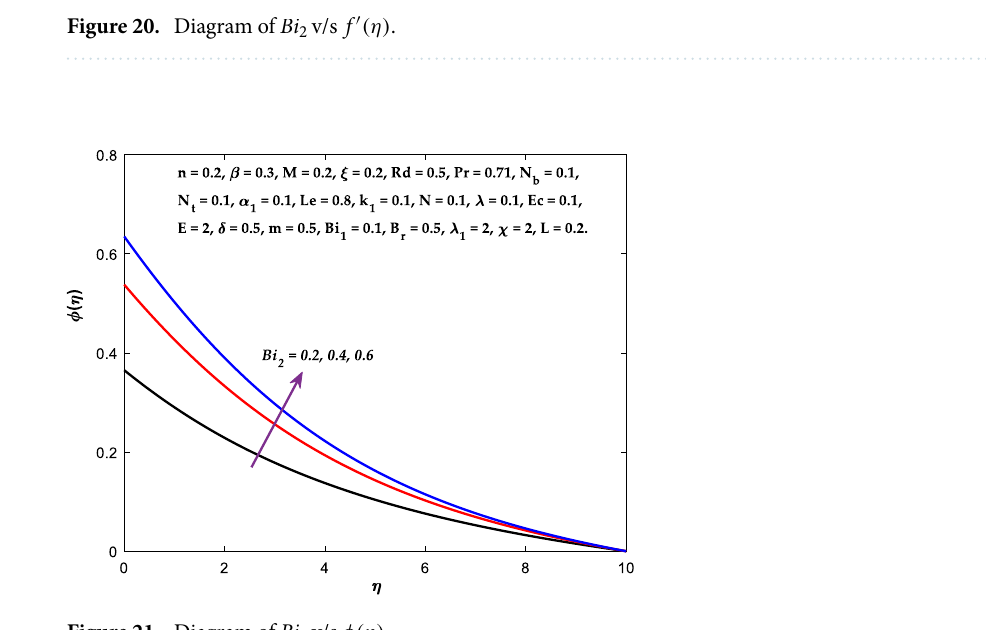
Figure 21. Diagram of Bi 2 v/s φ(η)